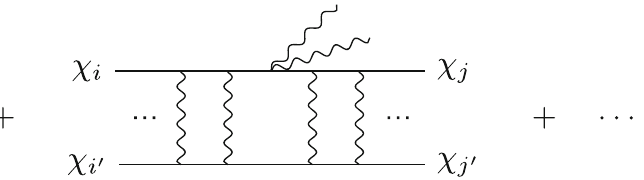
Fig. 9 Examples of diagrams controlling the BS effective Hamilto- nian at next-to-leading order in gauge boson emission The first diagram correspondstothesecondorderBornapproximationforthedipoleoper- ators inEq. (A.1), where theresummationofthevectorboson insertions